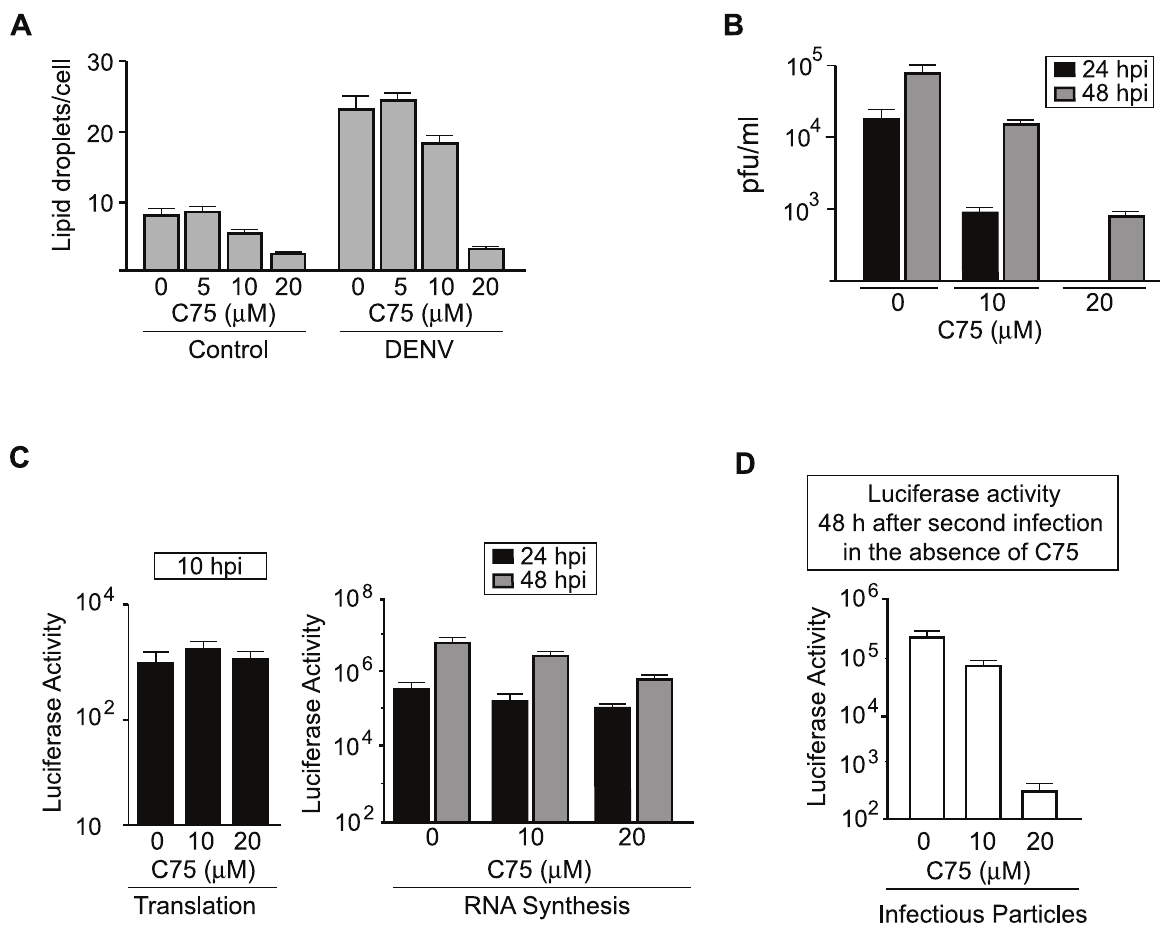
Figure 7. Pharmacological inhibition of lipid droplets accumulation impairs DENV replication. A. Effect of C75 on the amount of lipid droplets in BHK cells. The amount of lipid droplets was quantified in BHK cells treated with different concentrations of C75. Control or DENV infected BHK cells were used. B. Inhibition of DENV replication in cells treated with C75. The amount of infectious viral particles produced at 24 and 48 h post- infection in BHK cells were evaluated by plaque assays in control or C75 treated cells as indicated. Error bars indicate the SD of three independent experiments. C. Effect of C75 on each step of the replication of the mDV-R. Viral stocks of the reporter mDV-R were used to infect BHK cells in the presence and absence C75. Luciferase activity was evaluated at 10 h post-infection to evaluate entry and translation (left panel), and at 24 and 48 h to evaluate RNA synthesis (right panel). D. The production of infectious viral particles produced in the experiment described in C was evaluated by infecting fresh BHK cells in the absence of the inhibitor, and assessing the luciferase activity 48 h after